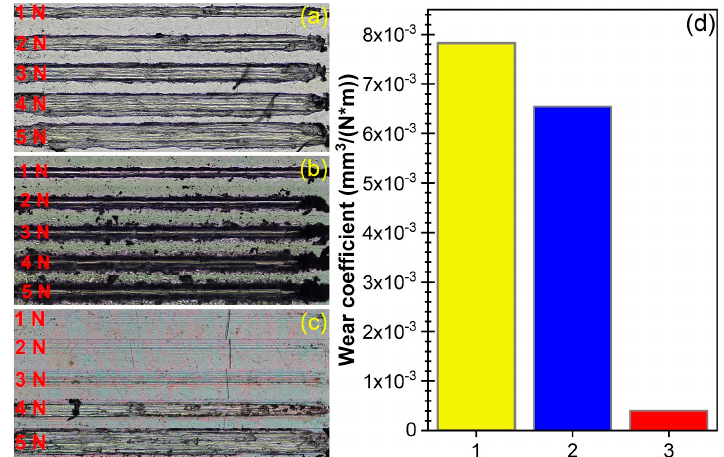
Figure 7. Optical microscopy images of the wear tracks recorded at five incremental load values (i.e., 1, 2, 3, 4 and 5 N), with 10 passes per load at a displacement rate of 4 mm/min, in the case of the ( a ) bare and ( b ) FastOs ® BG- and ( c ) Cu&Ga-FastOs ® BG-coated Ti substrate. ( d ) The wear coefficient determined for the three studied specimens under the load of 5 N.